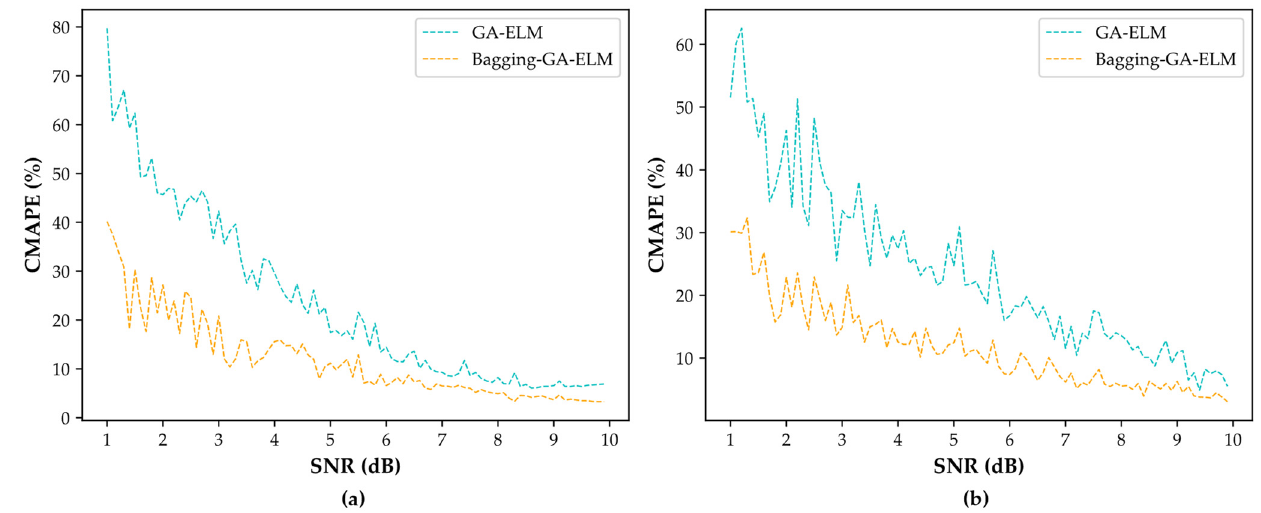
Figure 12. The performance of prediction models under different background noise. ( a ) Dimensional error of diameter I, (b) Dimensional error of diameter II.